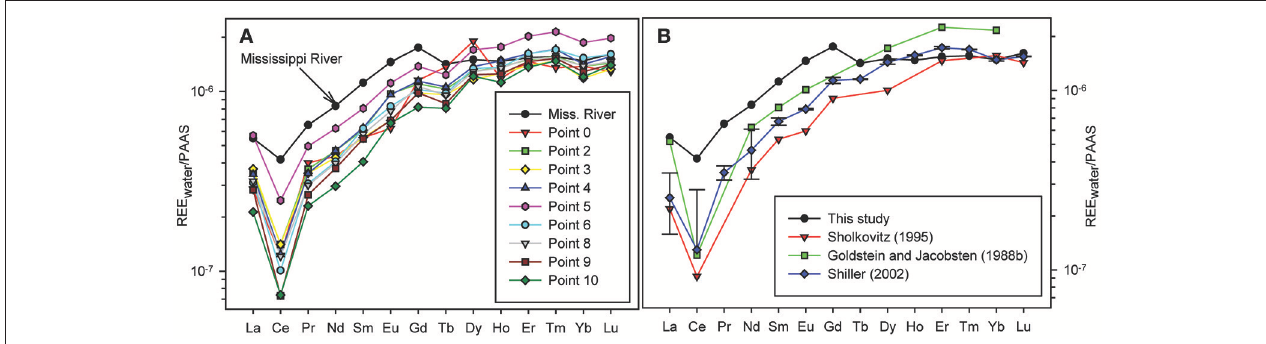
FIGURE 2 | (A) PAAS-normalized REE patterns for water samples collected from the Mississippi River and Louisiana Bight. (B) A comparison of Mississippi River water sample (salinity ≈ 0) from this study with previous studies. The data from Shiller (2002) are discharge-weighted mean values.